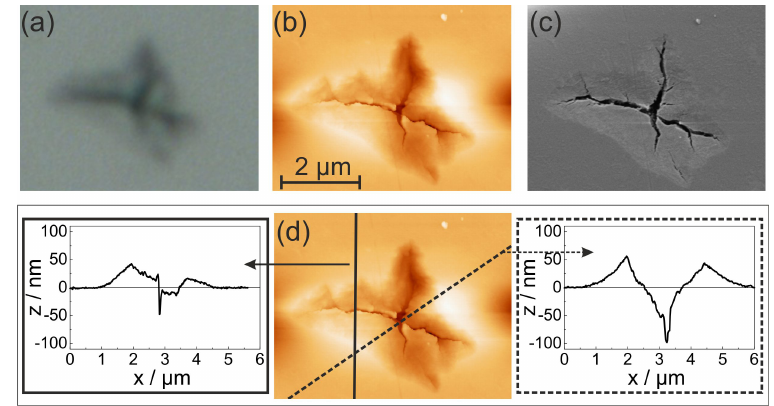
Figure 3. ( a ) Light microscope; ( b ) atomic force microscopy (AFM); and ( c ) SE-SEM image of the same crack of the 10 + 48 h pretreated LGS substrate; ( d ) shows the AFM line profiles across the crack.